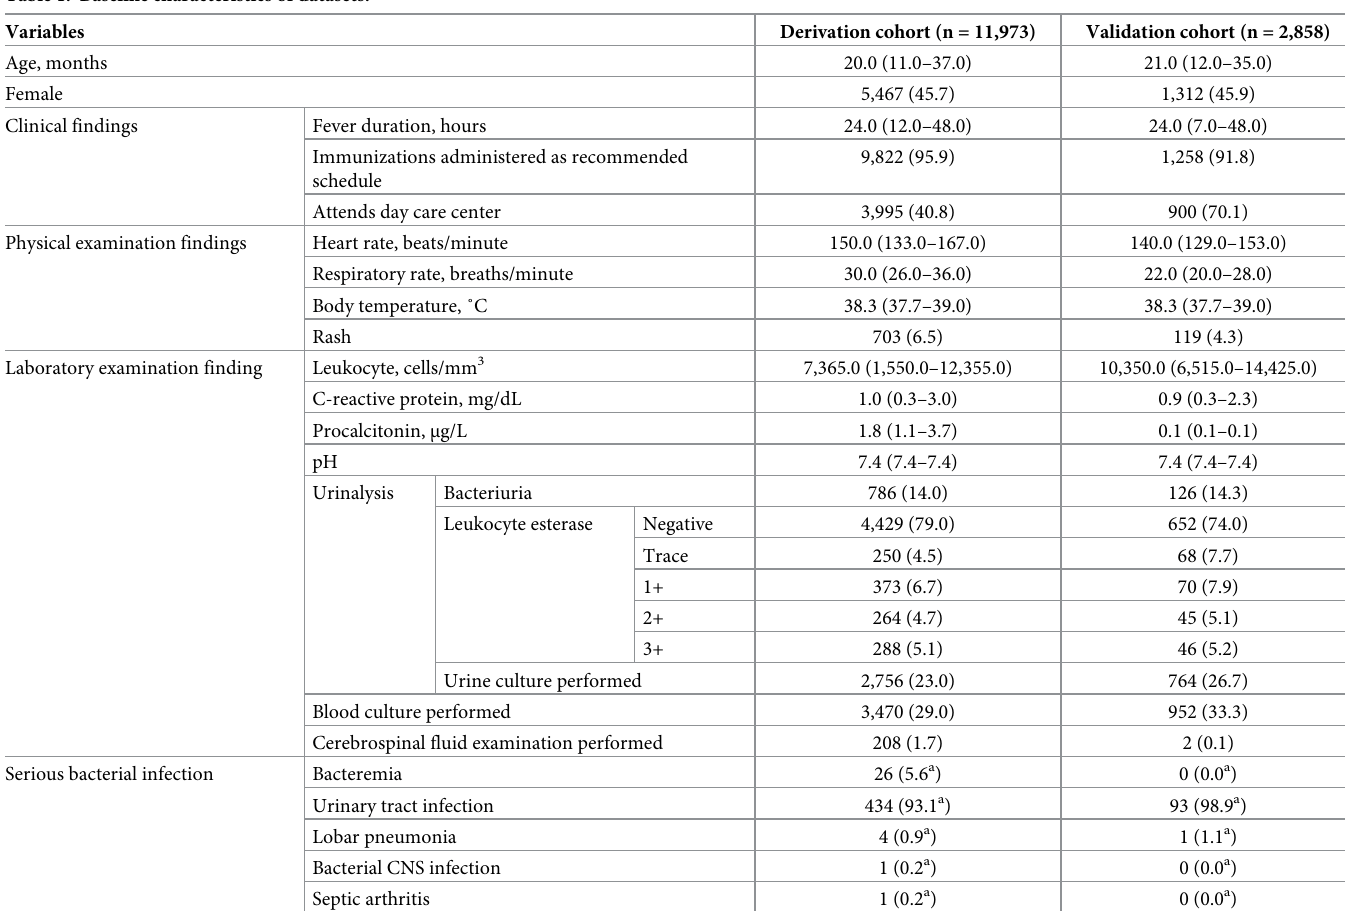
Table 1. Baseline characteristics of